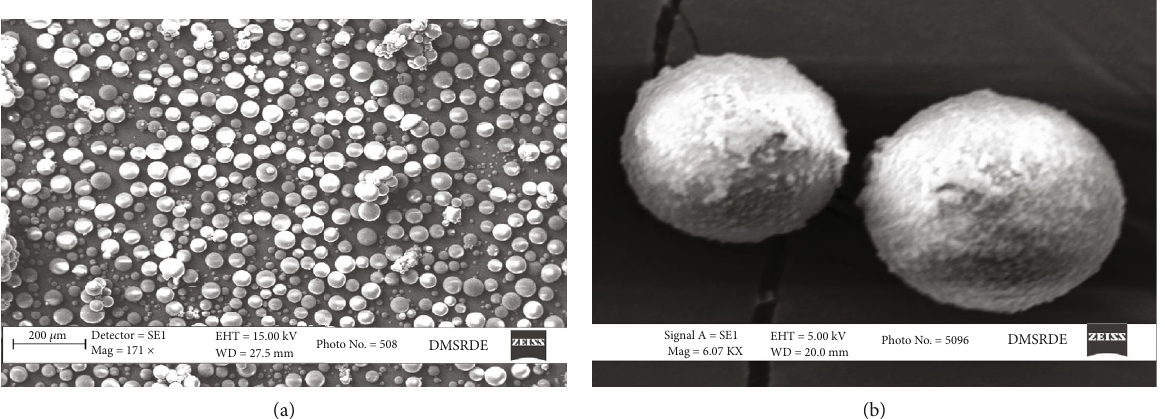
Figure 2: SEM micrographs of (a) uncoated and (b) MnO-coated hollow PMMA MS.